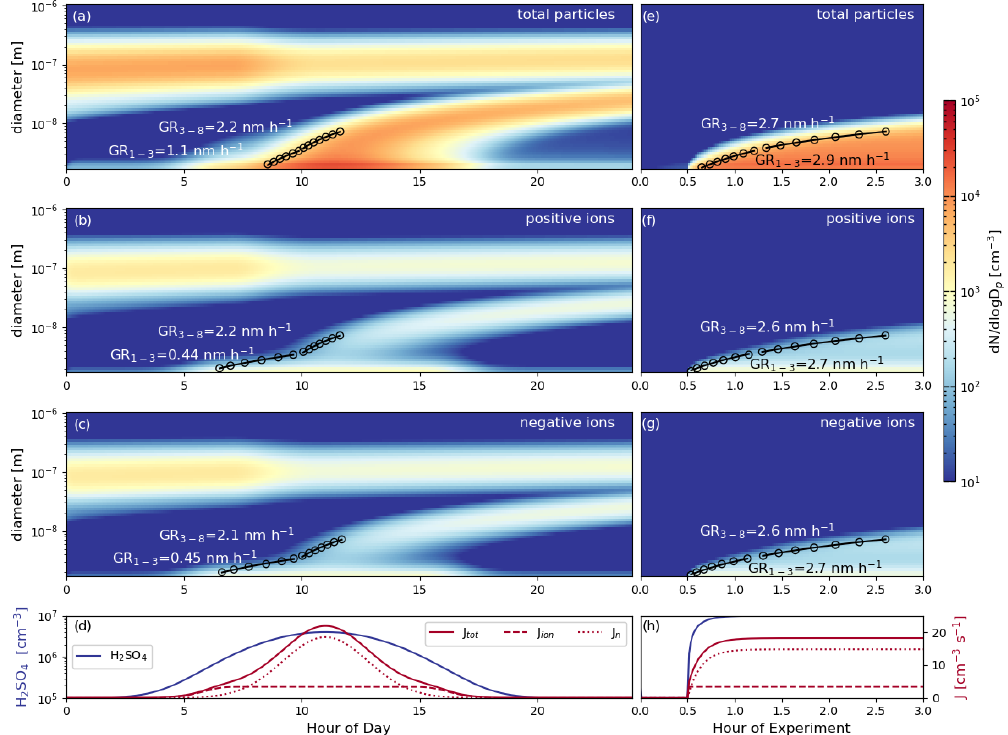
Figure 6. Ion-UHMA model results, with the J rates parametrized according to Lehtipalo et al. (2018) for both Hyytiälä (a–d) and CLOUD (e–h) conditions. Panels (a) and (e) show the total particle-size distribution. Panels (b) and (f) and (c) and (g) show the posi- tive and negative ion-size distribution, respectively. Panels (d) and (h) show the sulfuric acid concentration for vapor growth (blue) and the parametrized nucleation rate according to Lehtipalo et al. (2018), assuming typical profiles of [H 2 SO 4 ] 2 [NH 3 ] [HOM dim ] for Hyytiälä and